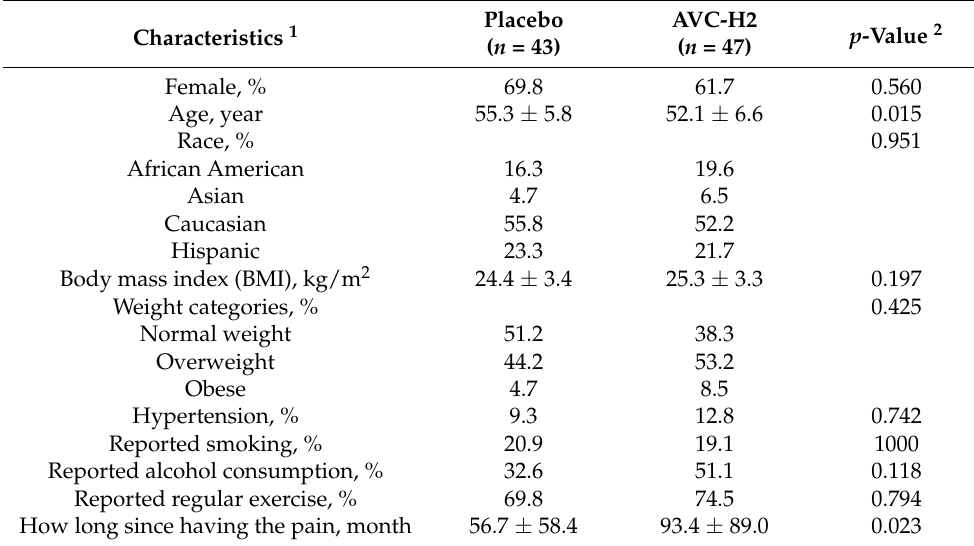
Table 1. Characteristics of the study participants at the